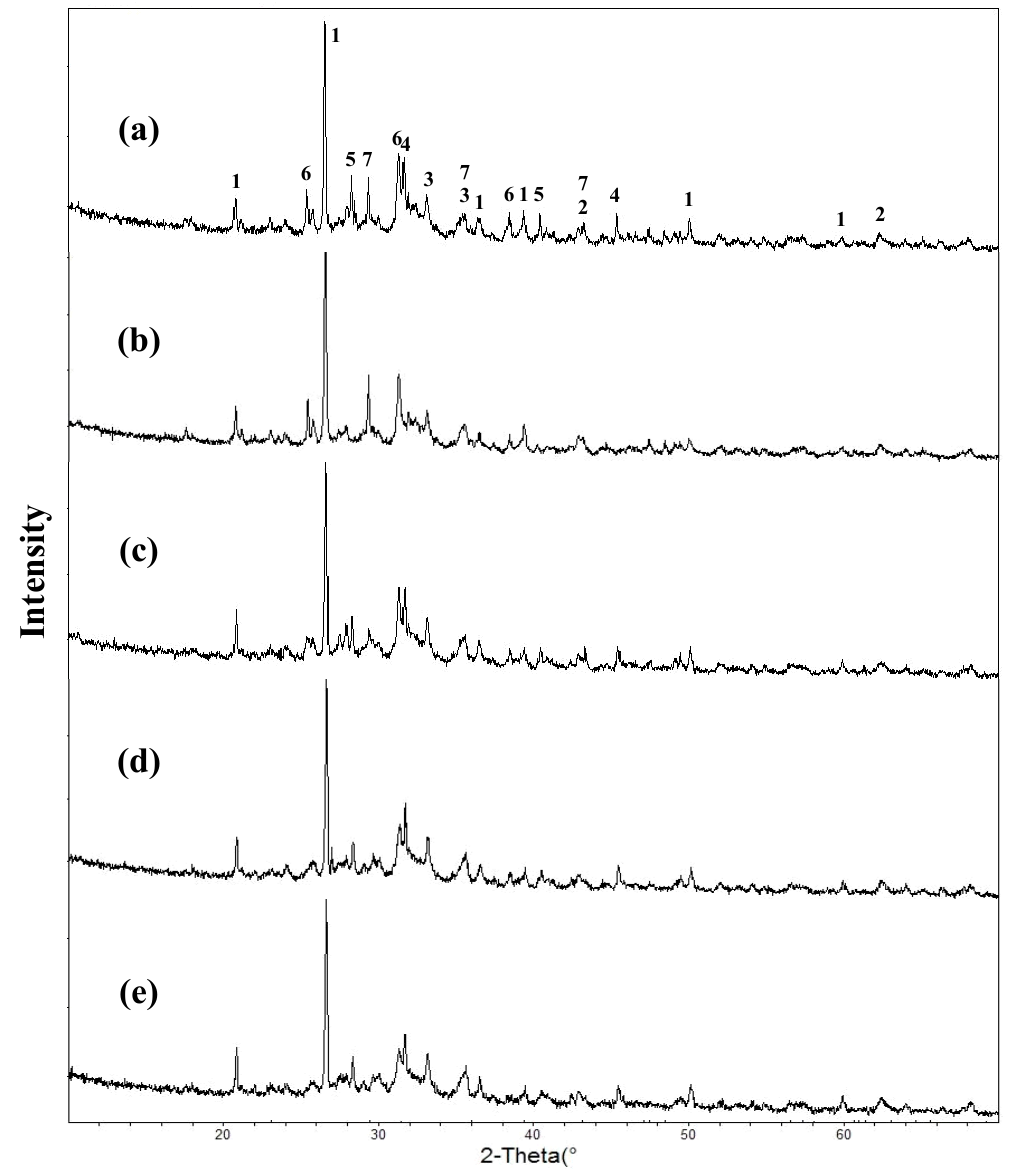
Figure 2. XRD patterns of ( a ) raw fly ash; ( b ) washed fly ash; ( c – e ) milled fly ash after ( c ) 1 h; ( d ) 4 h; ( e ) 10 h of milling. 1: SiO 2 , 2: MgO, 3: Fe 2 O 3 , 4: NaCl, 5: KCl, 6: CaSO 4 , 7: CaCO 3 .